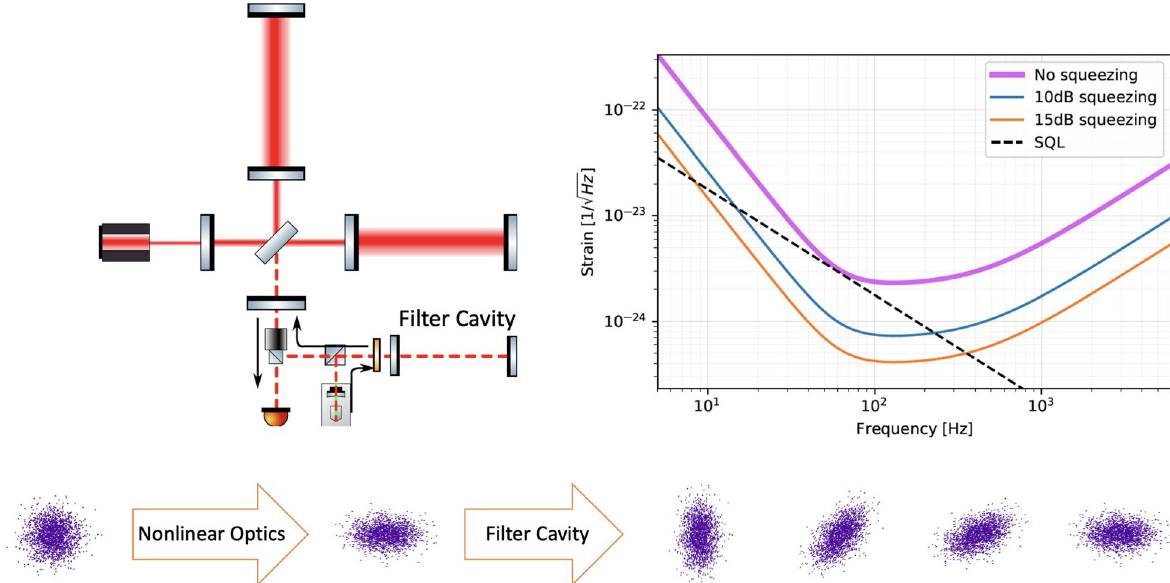
Fig. 5 Frequency-dependent squeezing enhancing Advanced LIGO in an ideal model. Filter cavities are applied to rotate the angle of squeezed state. A phase squeezing will be manipulated to the desired squeezing angle at different frequencies. The quantum vacuum noise was extracted from the noise budget of Advanced LIGO as shown in Fig. 1, recalculated with pygwinc [16]. By applying the frequency-dependent squeezing, quantum noise is reduced over a broad frequency band and the SQL can be surpassed in this